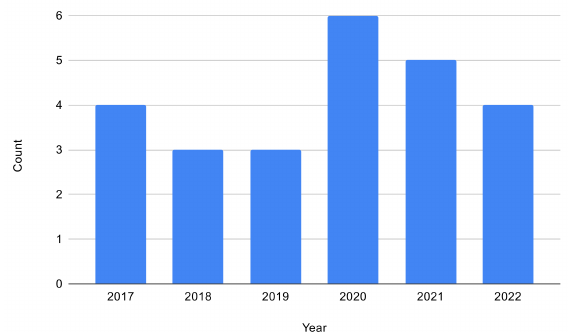
Figure 2. Papers by year of publication.